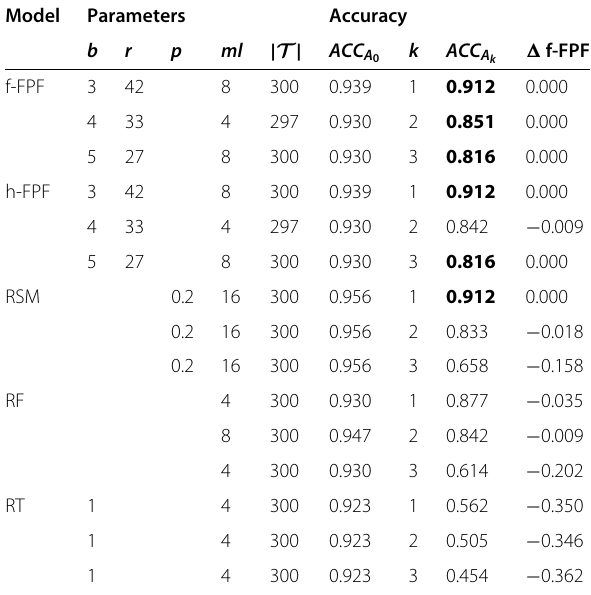
Table 3 Accuracy on the B REAST _C ANCER dataset (in boldface best results for each k ) Model Parameters